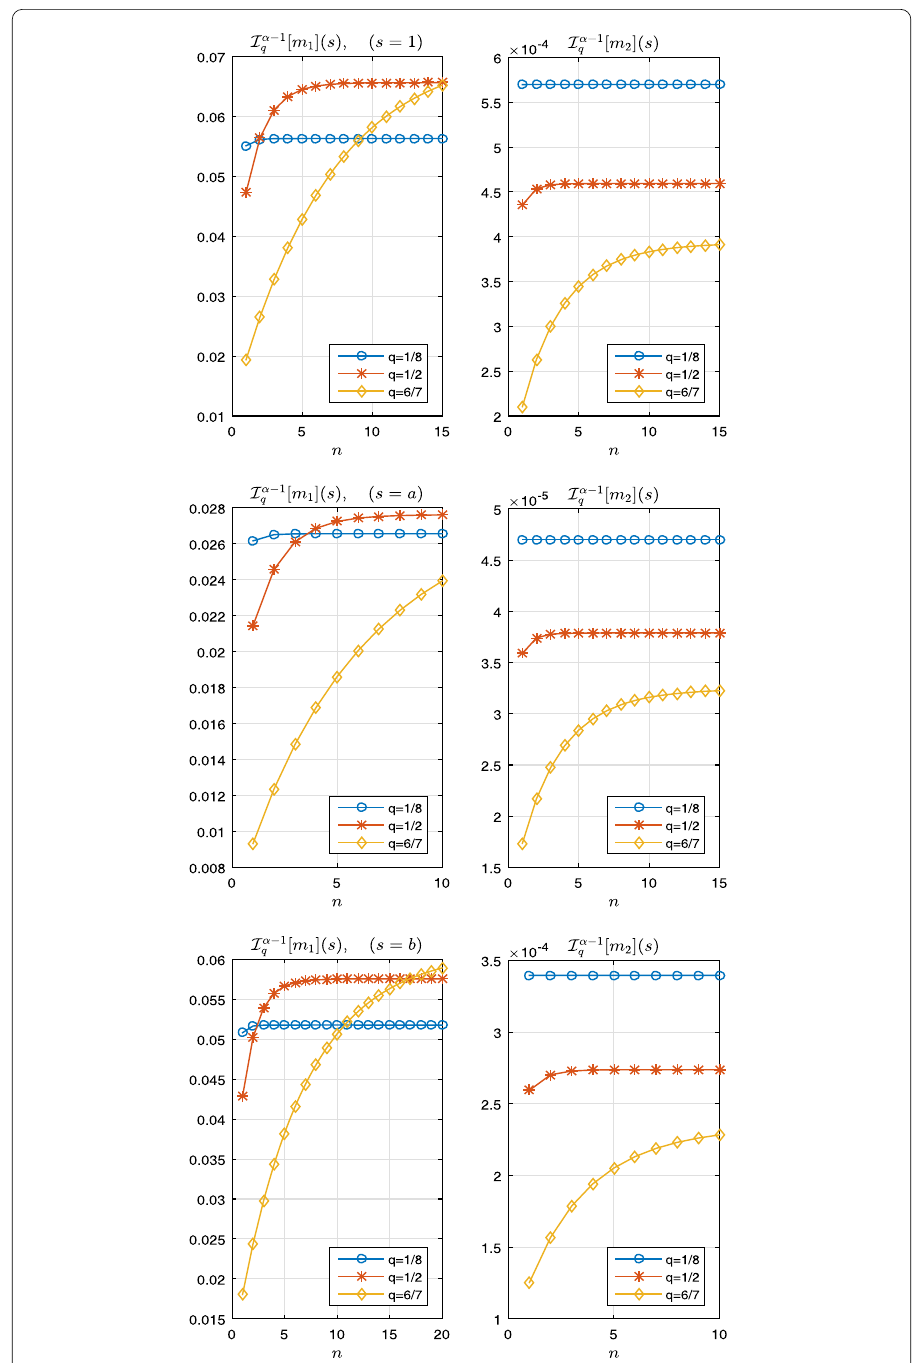
Figure 3 2D graph of I α –1 q [ m 1 ]( s ) and L I α –1 q [ m 2 ]( s ) for t ∈ J and s = 1, a , b with q = 1